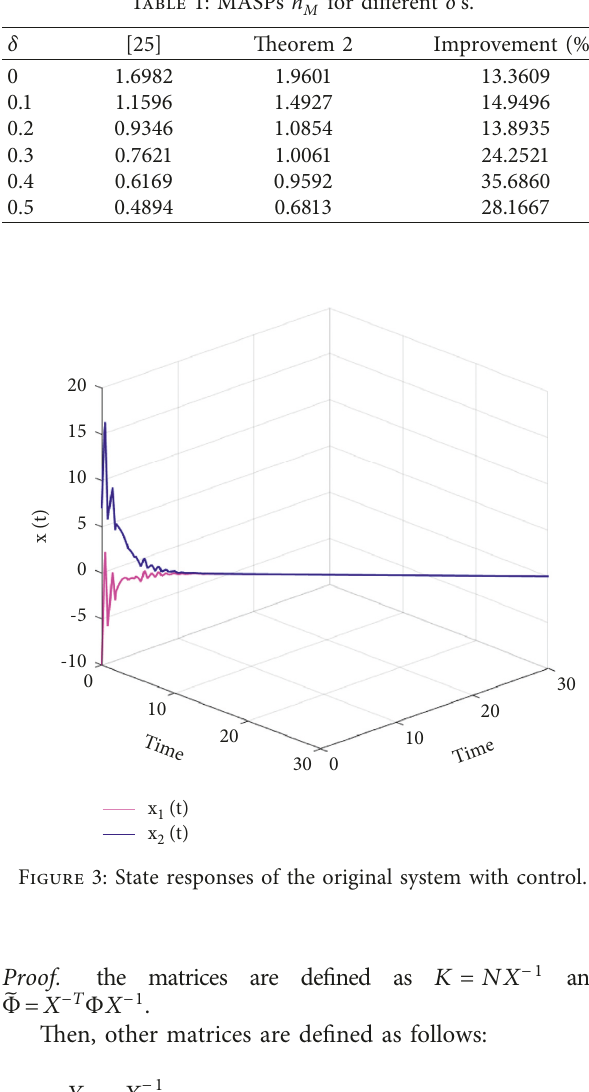
Table 1: MASPs h